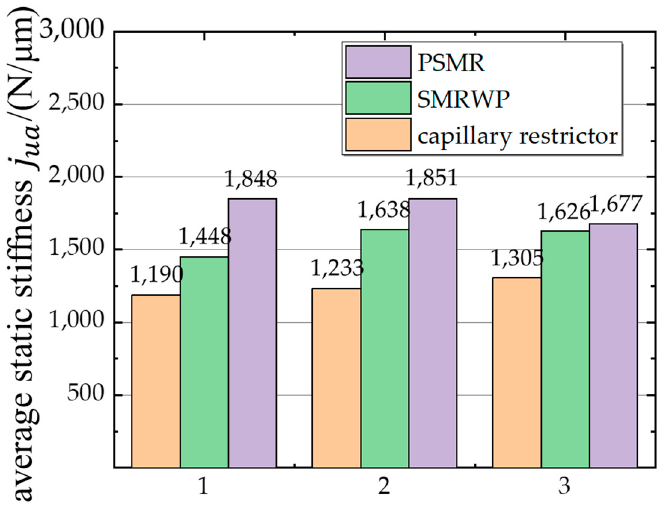
Figure 11. Simulation results of the average static stiffness of the three types of regulators.